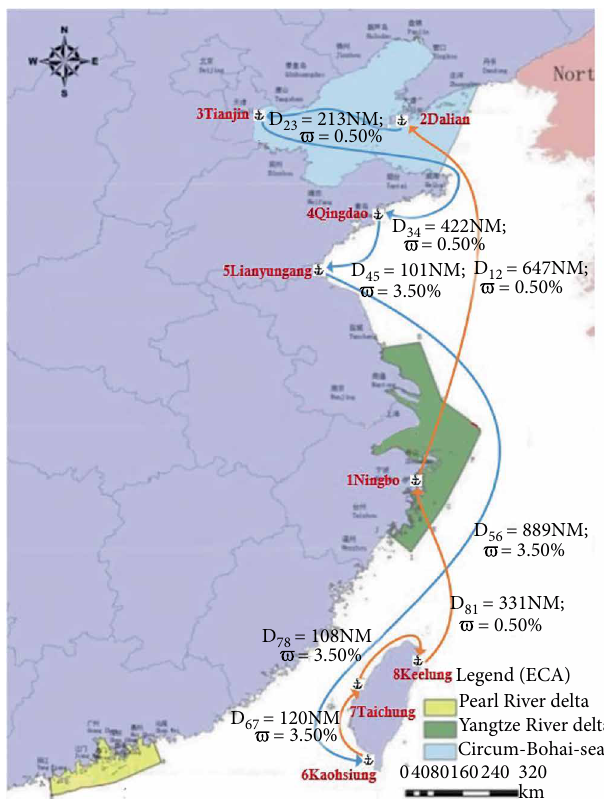
Figure 2: The OOCL containership service between Dalian and